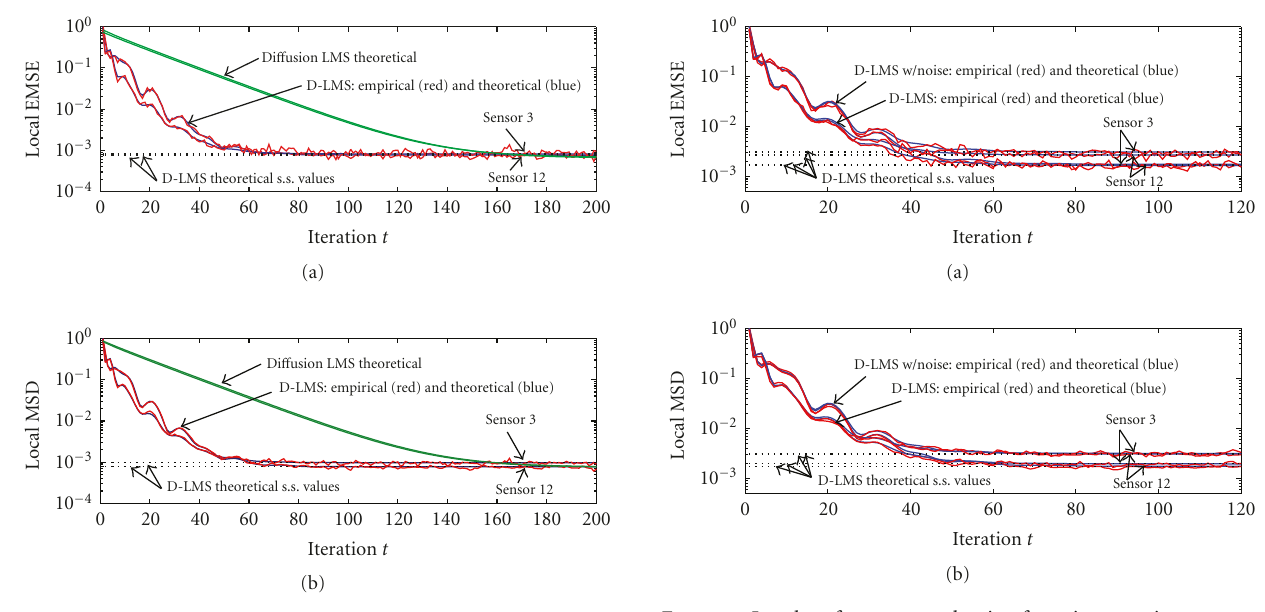
Figure 3: Local performance evaluation for a time-invariant parameter: empirical and theoretical curves for sensors 3 and 12 under ideal links.